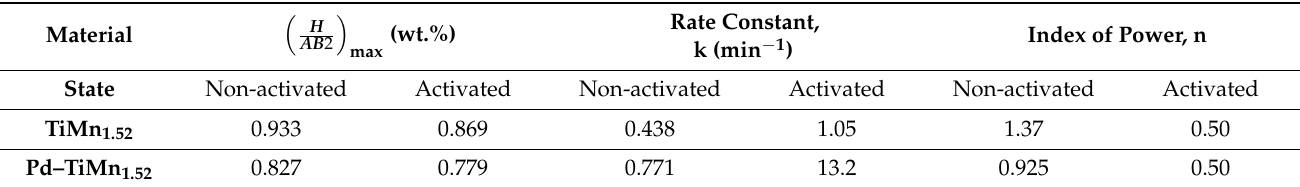
Table 2. Fit of the experimental data for hydrogen absorption by nonactivated and activated materials using the Avrami– Erofeev equation.